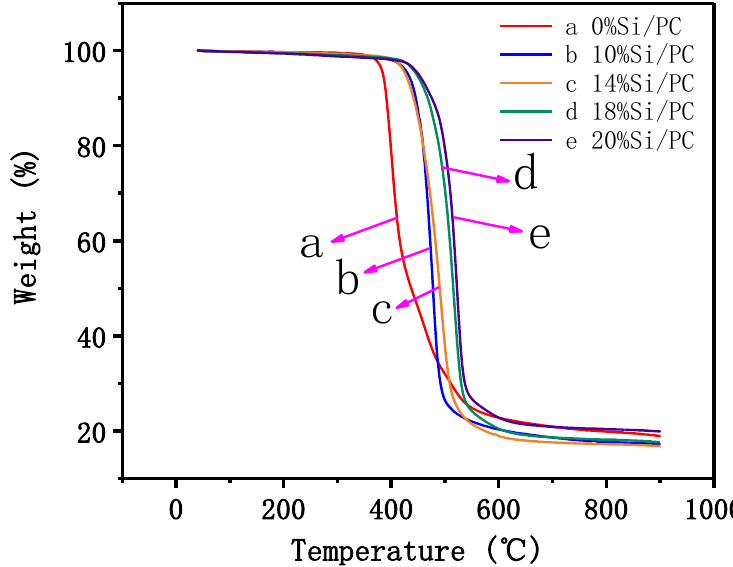
Figure 5. Thermal weight loss curves of 0%Si / PC ( a ), 10%Si / PC ( b ), 14%Si / PC ( c ), 18%Si / PC ( d ), and 20%Si / PC ( e ).